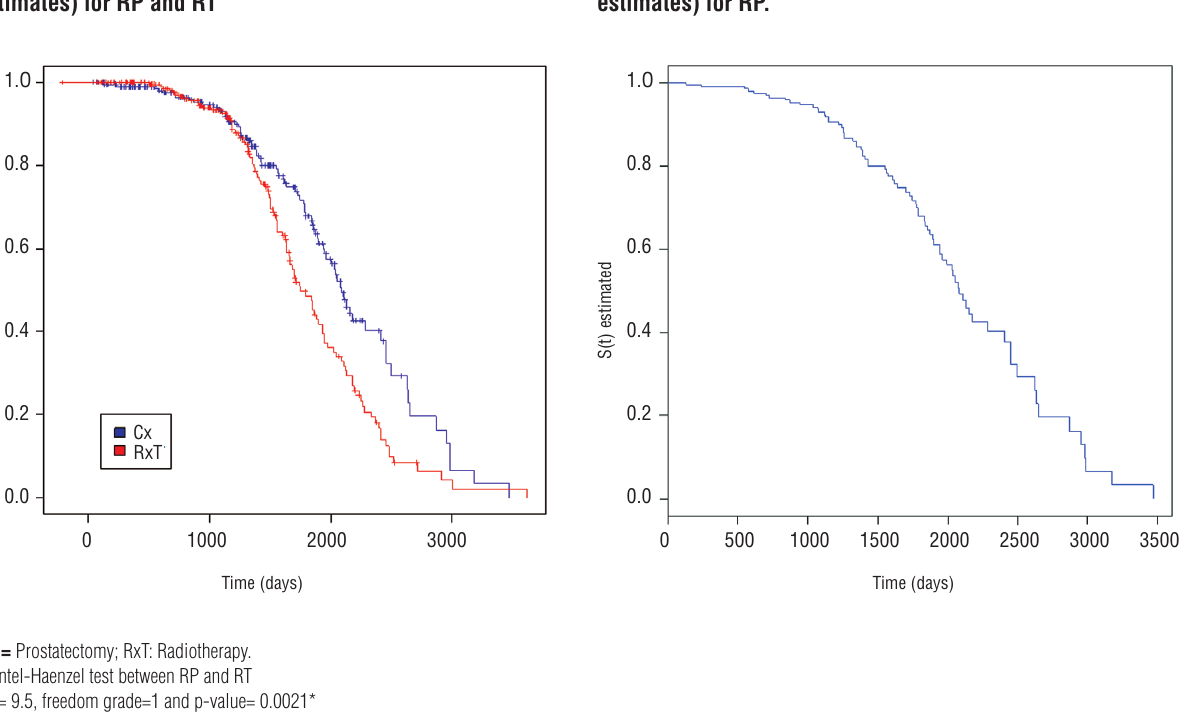
Figure 1 - Disease-free survival curves (Kaplan-Meier estimates) for RP and RT